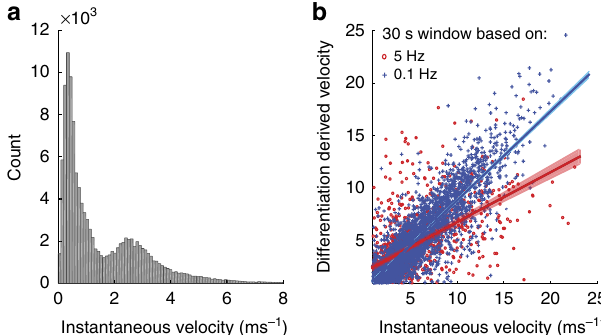
Figure 4 | Preferred speed and tortuosity estimates based on instantaneous velocity measures. ( a ) Histogram of instantaneous velocity measures during the daily 2h of 10s GPS fixes. ( b ) Differentiation derived velocity versus instantaneous velocity for walking and trotting (10s GPS fixes, blue, slope 0.84) and running (5Hz, red, slope 0.47), averaged for 30s windows. The lower ratio of differentiated to instantaneous velocity for running (5Hz) shows the higher tortuosity during